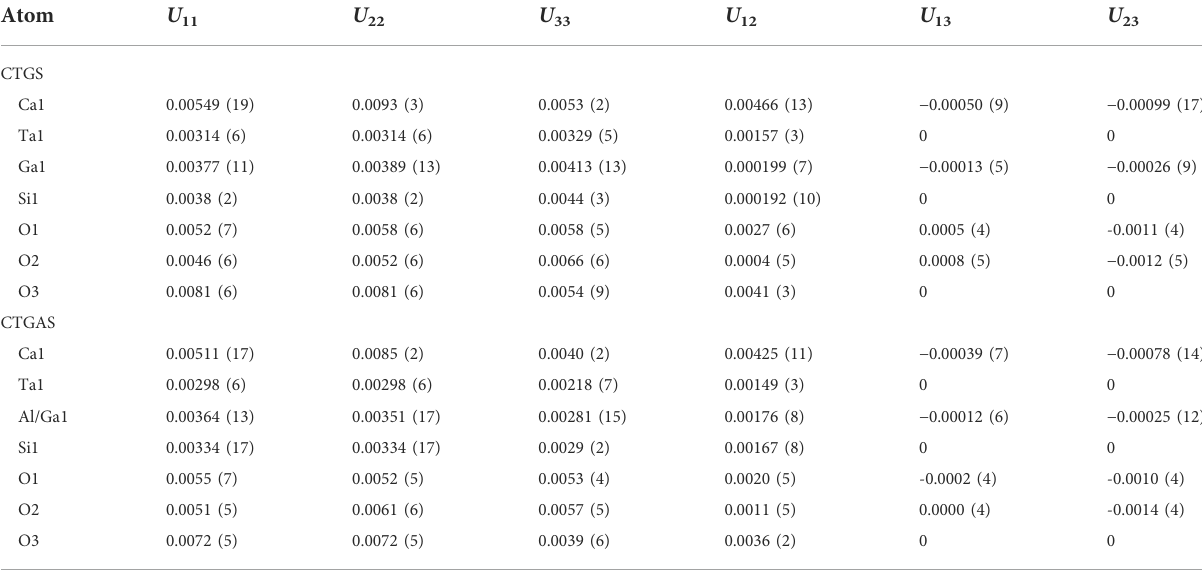
TABLE 3 Anisotropic displacement parameters ( U ij /Å 2 ) for CTGS and CTGAS.